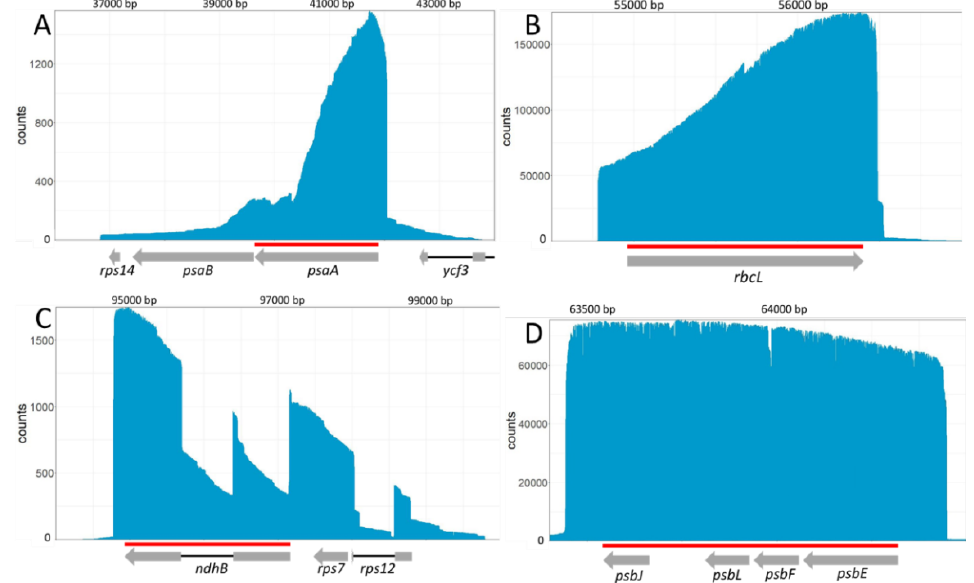
Figure 4. Examples of coverage biases in plastid transcripts. For each panel, the coverage at single- nucleotide resolution by strand-specific reads overlapping at least partially the genomic regions shown in red is shown. At the top, the genomic positions are shown while the coding sequences associated with these regions are shown below as gray arrows or boxes. Introns are represented as black lines. ( A ): psaA transcripts. ( B ): rbcL transcripts. ( C ): ndhB transcripts. ( D ): psbE-psbJ transcripts